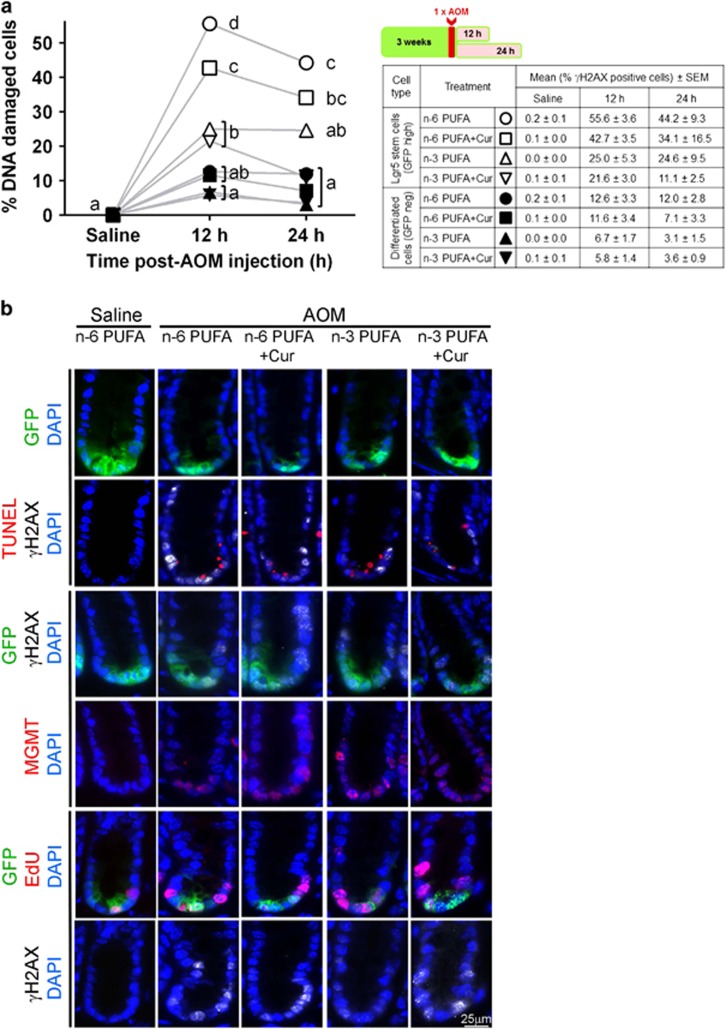
Effect of n-3 PUFA and curcumin on AOM-induced DNA DSBs in mouse colonic crypts at 12 and 24 h post AOM injection. (a) Comparison of γH2AX+ (DNA-damaged) stem and differentiated cells in the distal colon of saline (control) and 12 and 24 h post AOM-injected mice (left). GFP+ crypts from n=8 to 9 mice at 12 h, and n=3 for saline and 24 h were counted. Statistically significant differences between diets and treatments were determined using two-way analysis of variance (ANOVA), followed by Tukey's multiple comparison test adjustment. Different letters indicate significant differences between treatment groups in each time (P<0.05). Means and standard errors of the mean (S.E.M.) in different cell types, diets and treatments are listed in the table (right). Diets are labeled with different symbols and the open symbols refer to stem cells, whereas filled symbols refer to differentiated cells. (b) Representative images (objective, × 40) of GFP+ (Lgr5 stem cells, green), γH2AX+ (DNA DSBs, white) and TUNEL+ (apoptotic body, red) cells 12 h after AOM. Representative images of MGMT+ (DNA damage repair, red) and EdU+ (cell proliferation, red) cells 24 h following AOM exposure. Saline-injected animals serve as the control. n-6, n-6 PUFA; n-6+Cur, n-6 PUFA+curcumin; n-3, n-3 PUFA; n-3+Cur, n-3 PUFA+curcumin